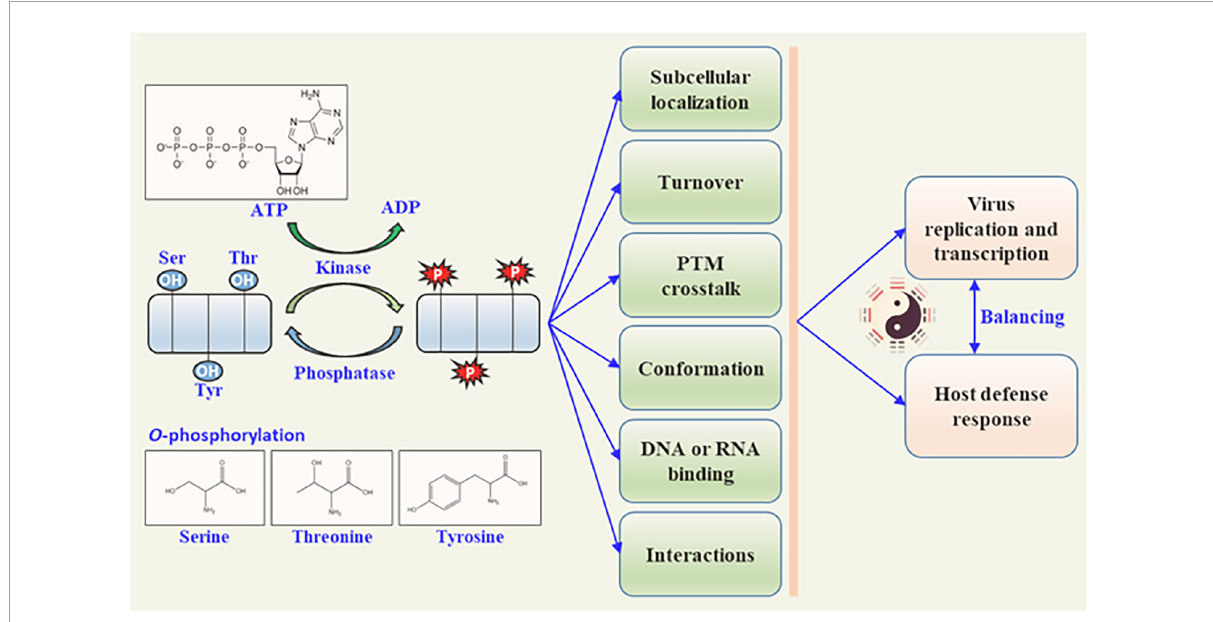
FIGURE1 Biological function of plant viral protein phosphorylation. Protein kinases phosphorylate plant viral proteins to regulate the viral protein activity by phosphorylation and dephosphorylation (catalyzed by phosphatases). The functions of viral proteins are altered in different ways, including subcellular location, pathogenicity, intrinsic biological activity, DNA or RNA binding activity, self-interaction, and interaction with other proteins. These functional changes in plant viral proteins further affect viral replication or transcription, and the host defense